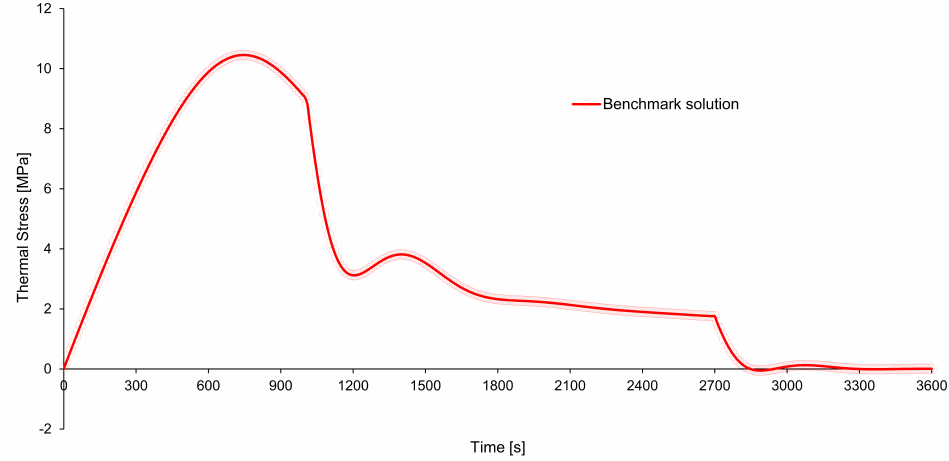
Figure 10. Change of the distance to the goal state over time with the benchmark solution.